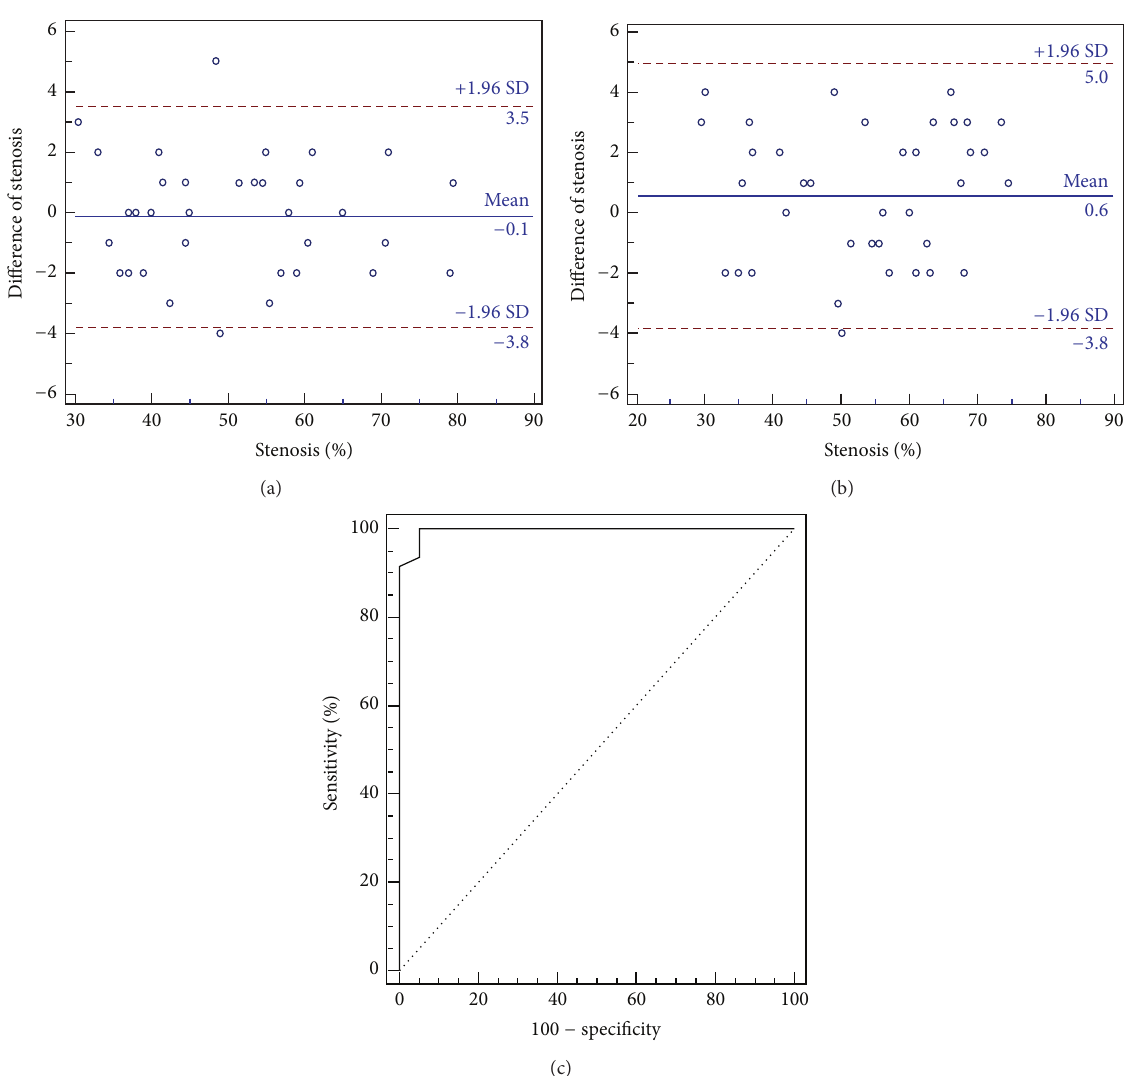
Figure 1: Bland-Altman plot reveals excellent concordance of measuring vasospasm severity according to locations such as proximal (a) and distal (b). (c) Receiver operating characteristic curves for detecting vasospasm ( > 50%) in all vessel segments ( > 30%). The area under the curve is 0.996. IV FDCT > 48% has a sensitivity of 93.6% and specificity of 94.7% in detecting hemodynamic significant vasospasm ( > 50%) with DSA as the reference (proximal arteries include distal internal carotid artery, M1 segment of the middle cerebral artery, A1 segment of the anterior cerebral artery, P1 segment of the posterior cerebral artery, and basilar